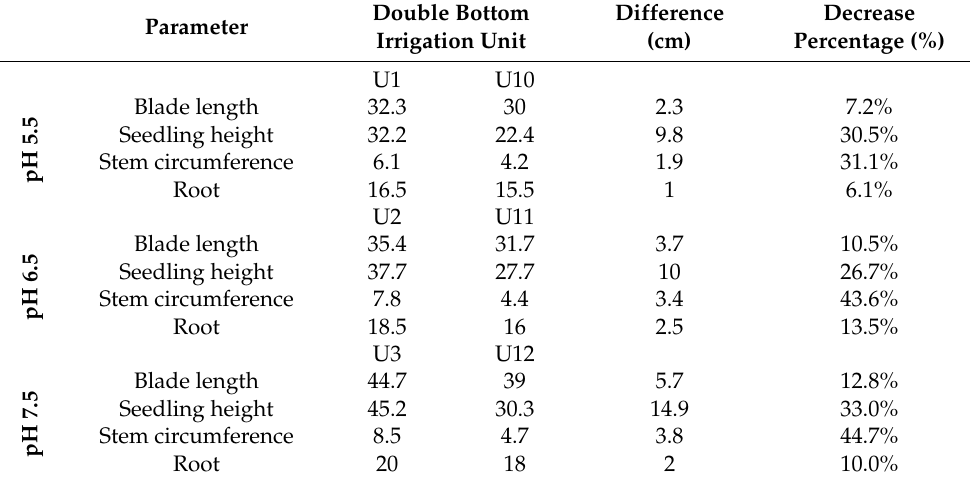
Figure 7. Response surface type graph handled in the experiment at 60 days, (leaves in centimeters) ( Z -axis). ( a ) Leaf length. ( b ) Seedling height. ( c ) Stem circumference. ( d ) Main root length. In all cases, the X axis indicates the level of lead contamination, concentration of (CPb), and the Y axis indicates the level of potential of hydrogen (pH) handled according to the experimental design. Data collected by the authors. Table 7. Comparison of the results of all the parameters contrasting double bottom irrigation units without lead and with the maximum lead concentration (CPb) at 60